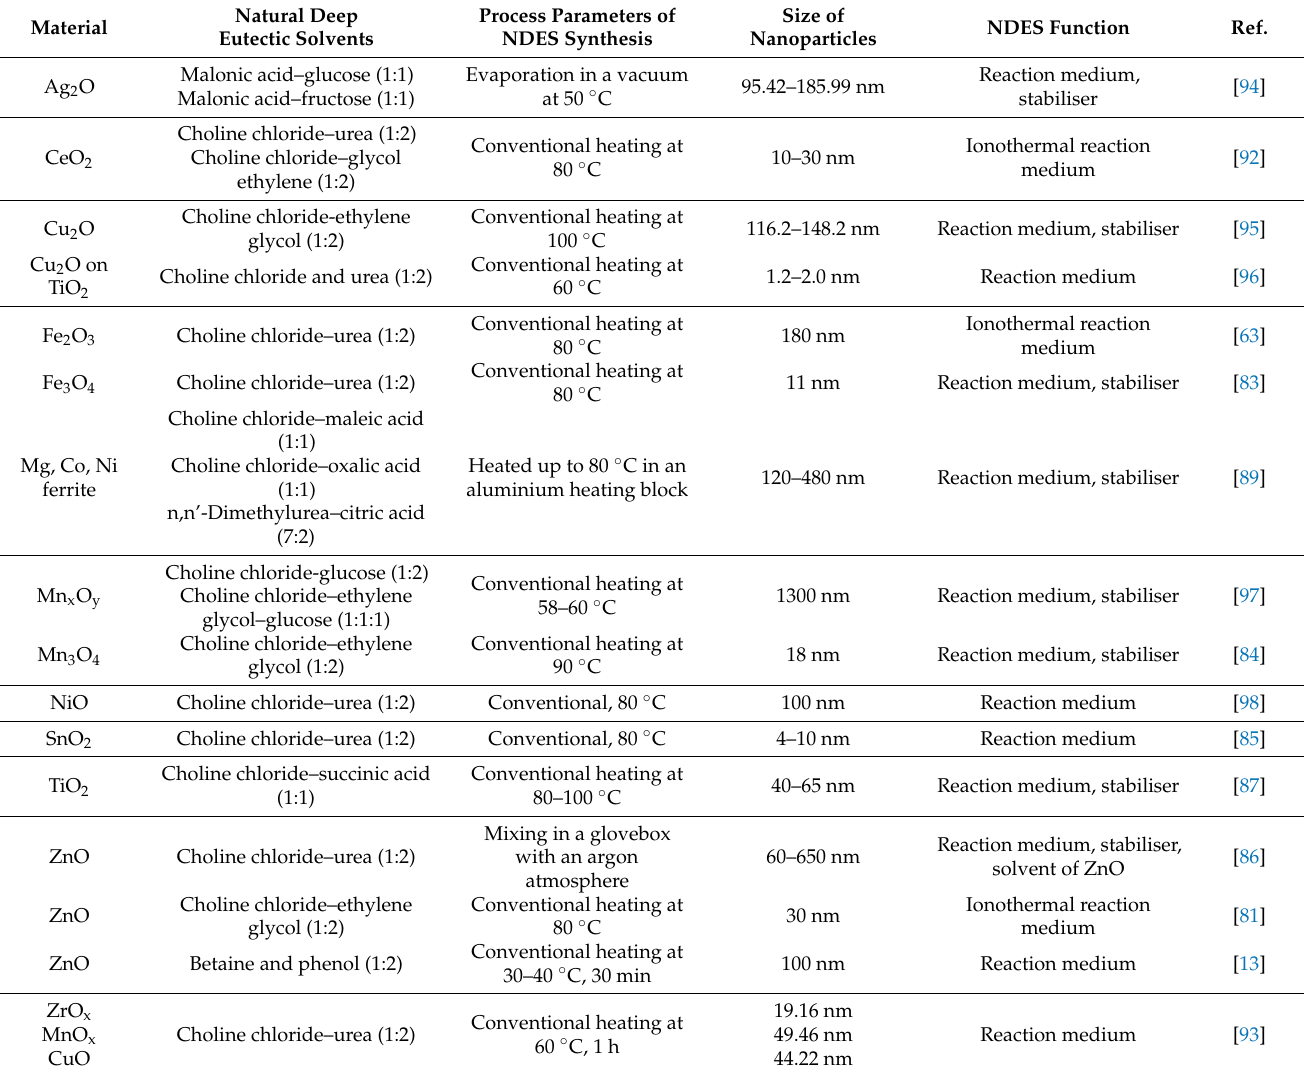
Table 3. Metal oxide nanoparticles obtained using NDESs with a description of the method of obtaining the NDESs and the functions they perform in the